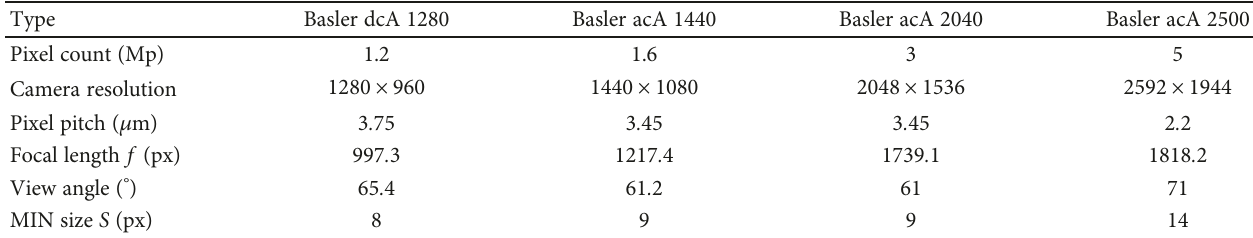
Table 2: Camera data.